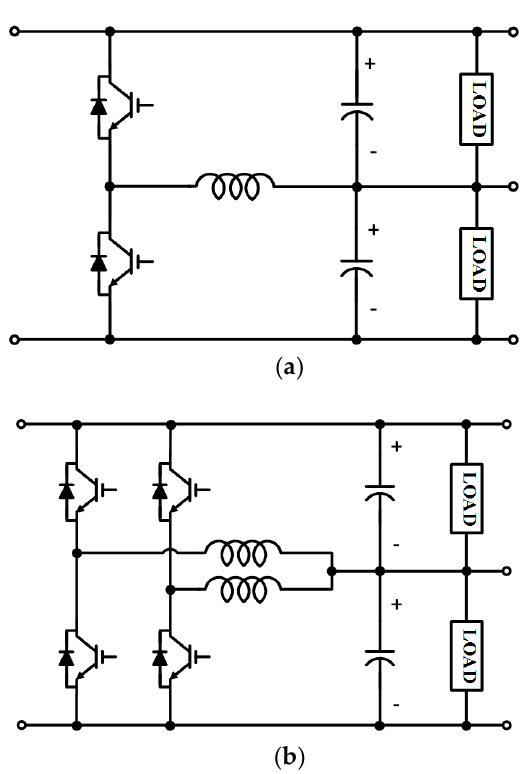
Figure 2. The circuit configuration of early proposed voltage balancer (VB): ( a ) Half-bridge type; ( b ) interleaved buck type.